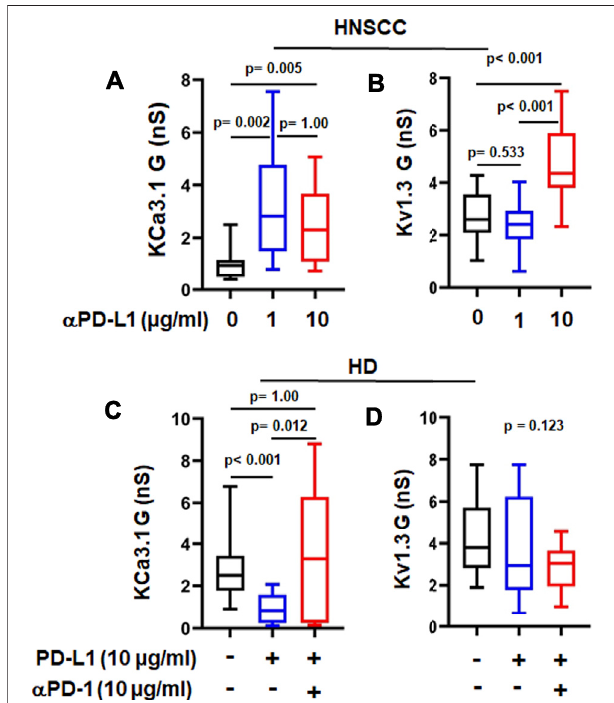
FIGURE 3 | α PD-L1 treatment increases K + channel activity in HNSCC patients. (A) KCa3.1 and (B) Kv1.3 conductance values (G) measured with and without the α PD-L1 antibody, atezolizumab (1 and 10 μ g/ml for 6 h) in activated CD8 + PBTs of HNSCC patients. (C) KCa3.1 and (D) Kv1.3 G measured in presence of PD-L1 and α PD-1 antibody pembrolizumab in activated CD8 + PBTs of HDs. Activated cells were treated with plate-bound PD-L1(PD-L1-Fc10 μ g/ml)+/- α PD-1(untreatedcellswereusedasacontrol) and activated for 72 h using PMA/Ionomycin. α PD-1 was added to treatment groupfor6 h.Datainthelowerandupperboundoftheboxrepresent25 th and 75 th percentilesrespectively.Medianvaluesareshownashorizontallines.The lower and upper error bars represents 10 th and 90 th percentile respectively, n (cid:1) 8 – 23 cells from 3 HNSCC patients, n (cid:1) 30 cells from 6 HDs (control and PD-L1)and n (cid:1) 15cellsfrom3HDs(PD-L1+ α PD-1).Fivecellswererecorded for each individual donor. Data in (A,C,D) were analyzed by ANOVA on ranks test ( p < 0.001) followed by Dunn ’ s post hoc analysis. Data in (B) were analyzed by One way ANOVA ( p < 0.001) followed by Holm-Sidak